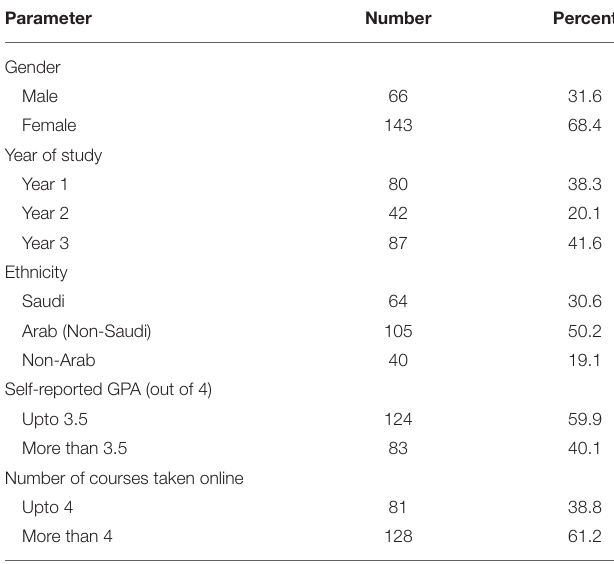
TABLE 1 | Demographic data of participating preclinical students ( N =